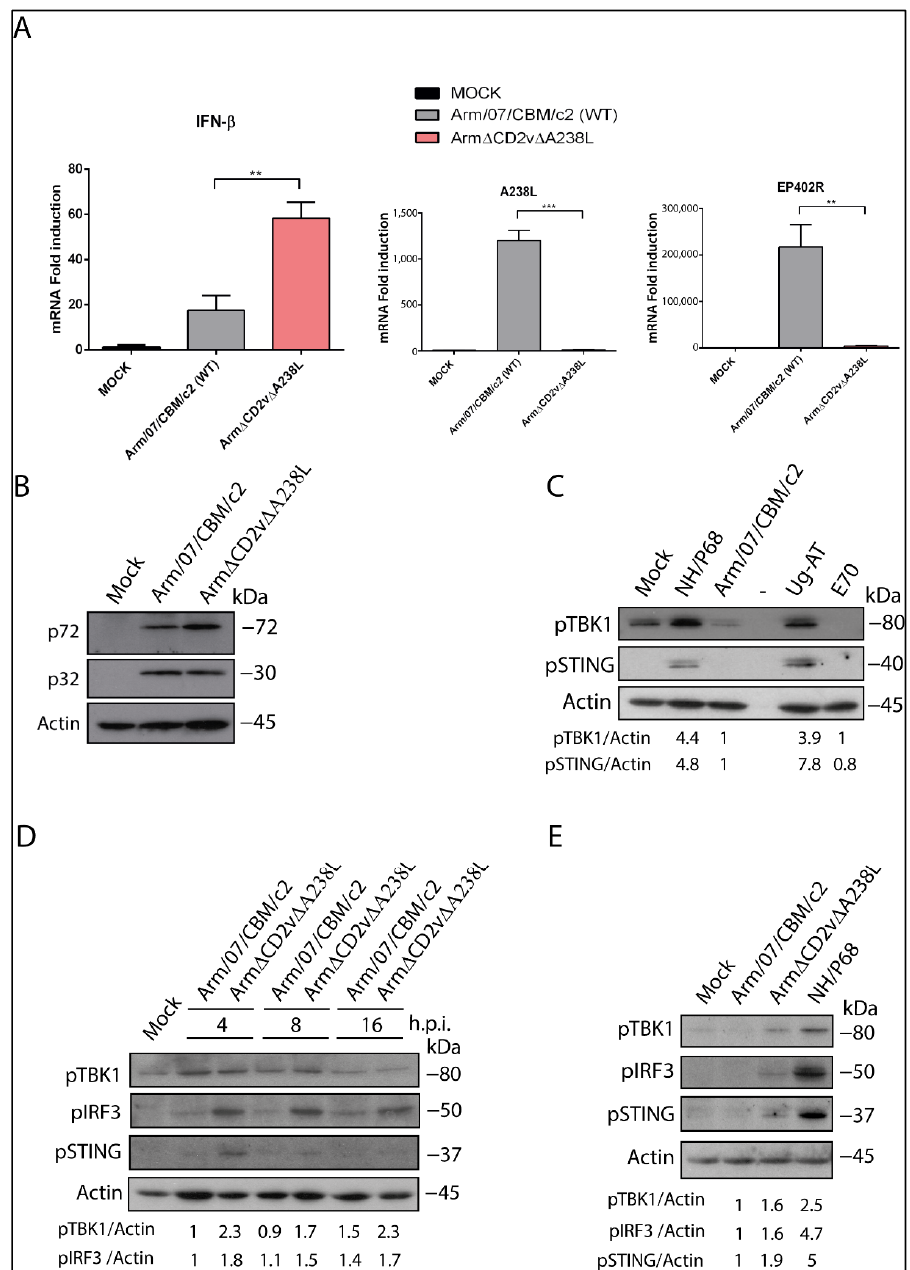
Figure 3. Arm- Δ CD2v- Δ A238L shows an attenuated phenotype in vitro. ( A ) IFN- β and viral genes EP402R and A238L mRNA was measured by qPCR in PAMs infected with either Arm- Δ CD2v- Δ A238L or Arm/07/CBM/c2 wild-type at 16 hpi, MOI = 3. ( B ) Viral protein expression was measured by Western blot. Cells were lysed in RIPA buffer at 16 hpi, MOI = 3, and lysates were separated by 7 to 20% SDS-PAGE, followed by immunoblotting with anti-ASFV p32, anti-ASFV p72 and anti-actin antibodies. ( C – E ) Activation of cGAS-STING pathway in PAMs infected with ( C ) attenuated (NH/P68 and Ug-AT) or virulent (Arm/07/CBM/c2 and E70) ASFV strains at 16 hpi; ( D ) Arm/07/CBM/c2 vs. Arm- Δ CD2v- Δ A238L at 4, 8 and 16 hpi; and ( E ) Arm/07/CBM/c2, Arm- Δ CD2v- Δ A238L and NH/P68 at 4 hpi. In all cases, the activation of cGAS-STING pathway was evaluated by phosphorylation status of cGAS, TBK1 and IRF3 by Western blot. Cells were lysed in RIPA buffer at 4, 8 and 16 hpi, MOI = 2, and lysates were separated by 7 to 20% SDS-PAGE, followed by immunoblotting with anti-pSTING, anti-pTBK1, anti-pIRF3 and anti-actin antibodies. **: p -value < 0.01; ***: p -value < 0.001. Two-way ANOVA-test performed with